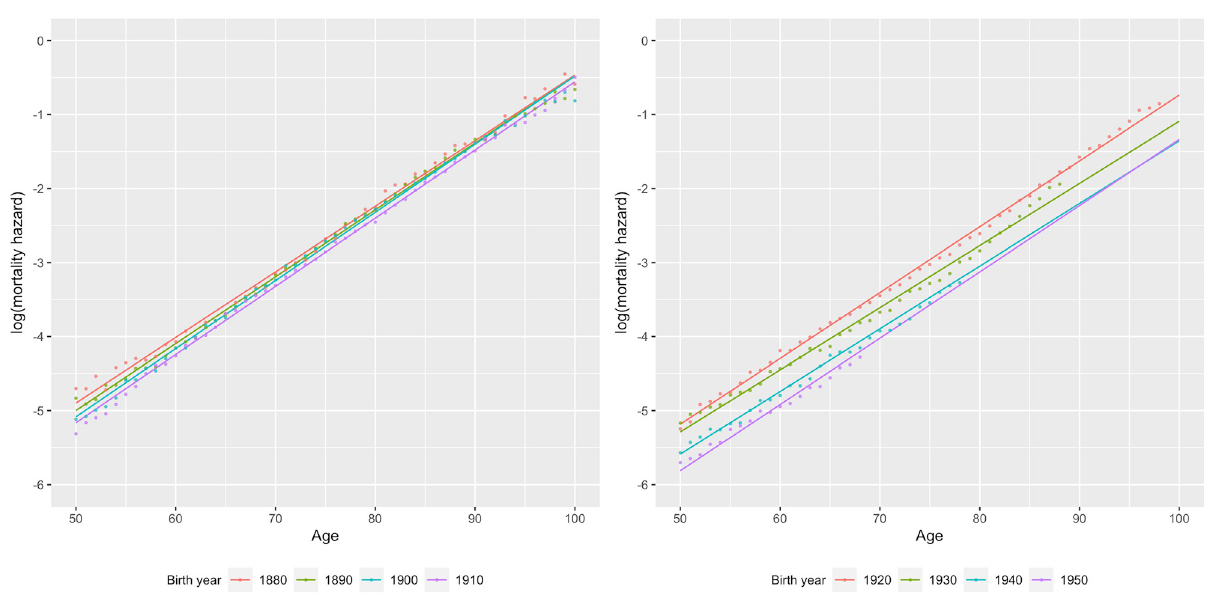
Fig 5. Observed mortality hazard rates (dots) and estimated base mortality hazard rates (lines) by age for Swedish males born 1880–1950. N OTE : Estimated base mortality rates are calculated using modal estimates ^ l